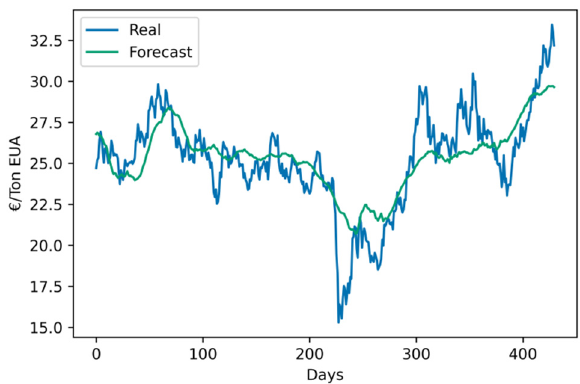
Figure 5. One-day-ahead prediction for the whole data set.